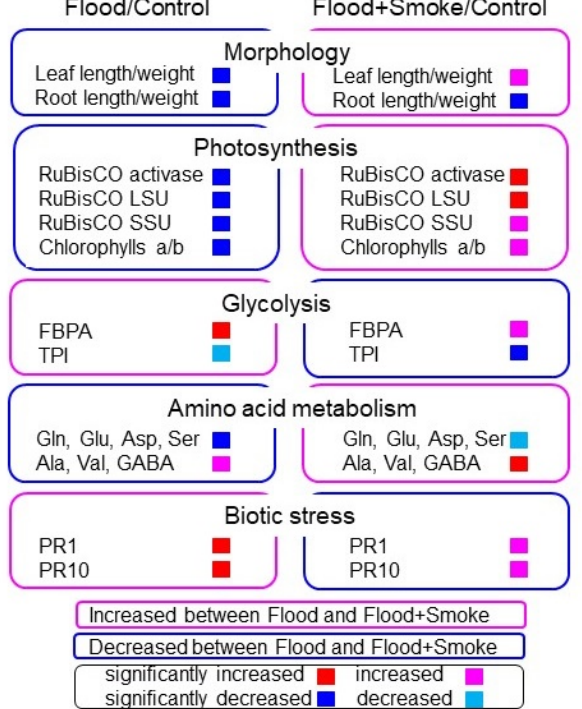
Figure 10. The overall responses of the main proteins in the functional categories in wheat leaf to the plant-derived smoke solution under flooding stress.